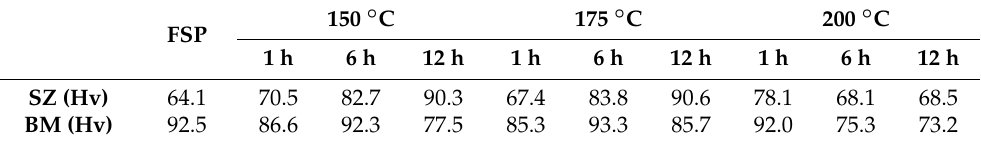
Table 3. Average Vickers microhardness for FSP and artificially aged AA6082